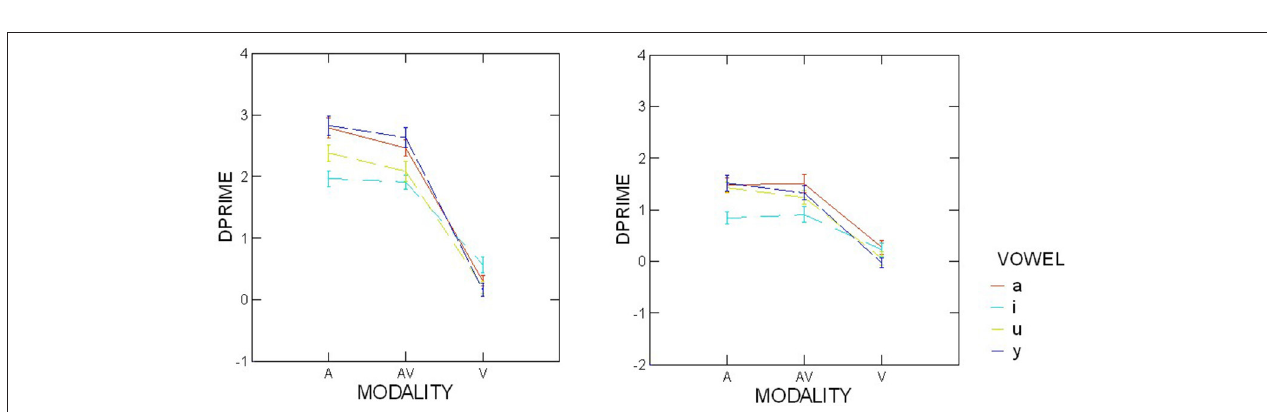
FIGURE 6 | Average d’ scores for adults (Left) and children (Right) , for each modality and vowel. AV, audiovisual; A, audio; V, visual. Error bars are standard errors.